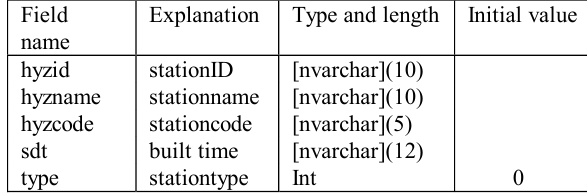
Table 1. Spatial attribute table of observation